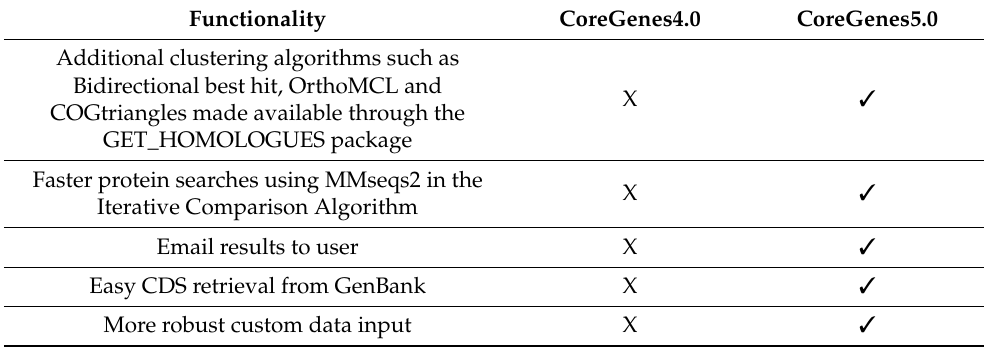
Table 1. Additional functionality provided by CoreGenes5.0 compared to CoreGenes4.0.